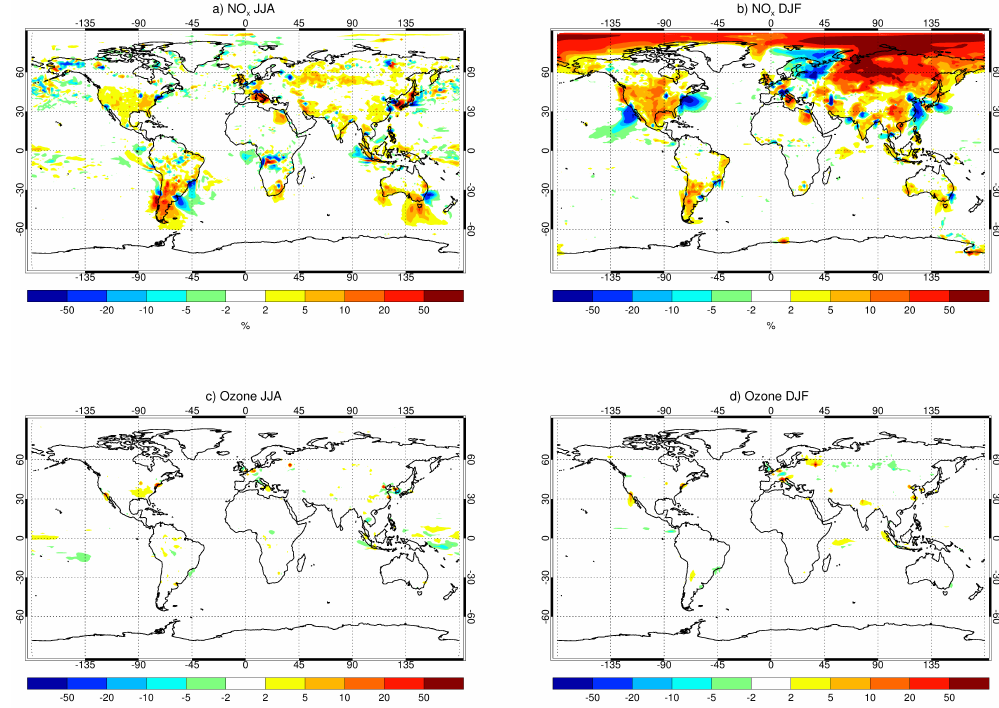
Fig. 2. Global surface differences showing the effect of redistributing 100% of megacity anthropogenic emissions compared to a control run. Seasonal mean differences are shown for JJA (left column) and DJF (right column) for NO x (top row) and ozone (bottom row). Differences are as percentage change ( redistribution-base base × 100 ).